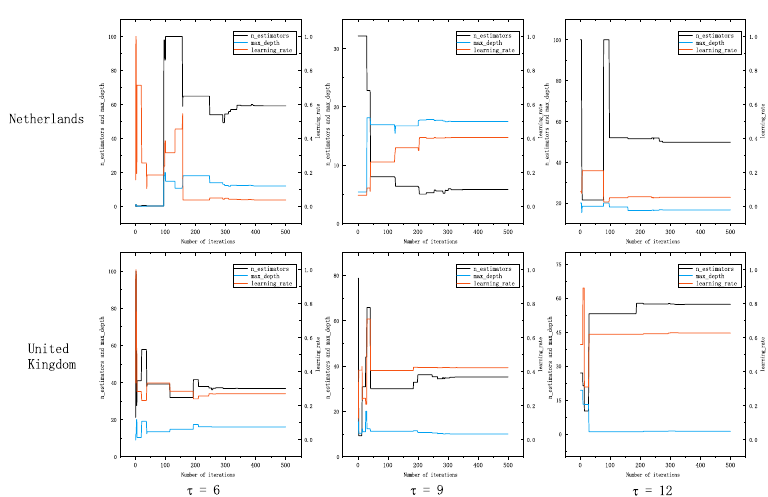
Figure 12. Convergence curves of hyperparameters of XGBoost by SSA.